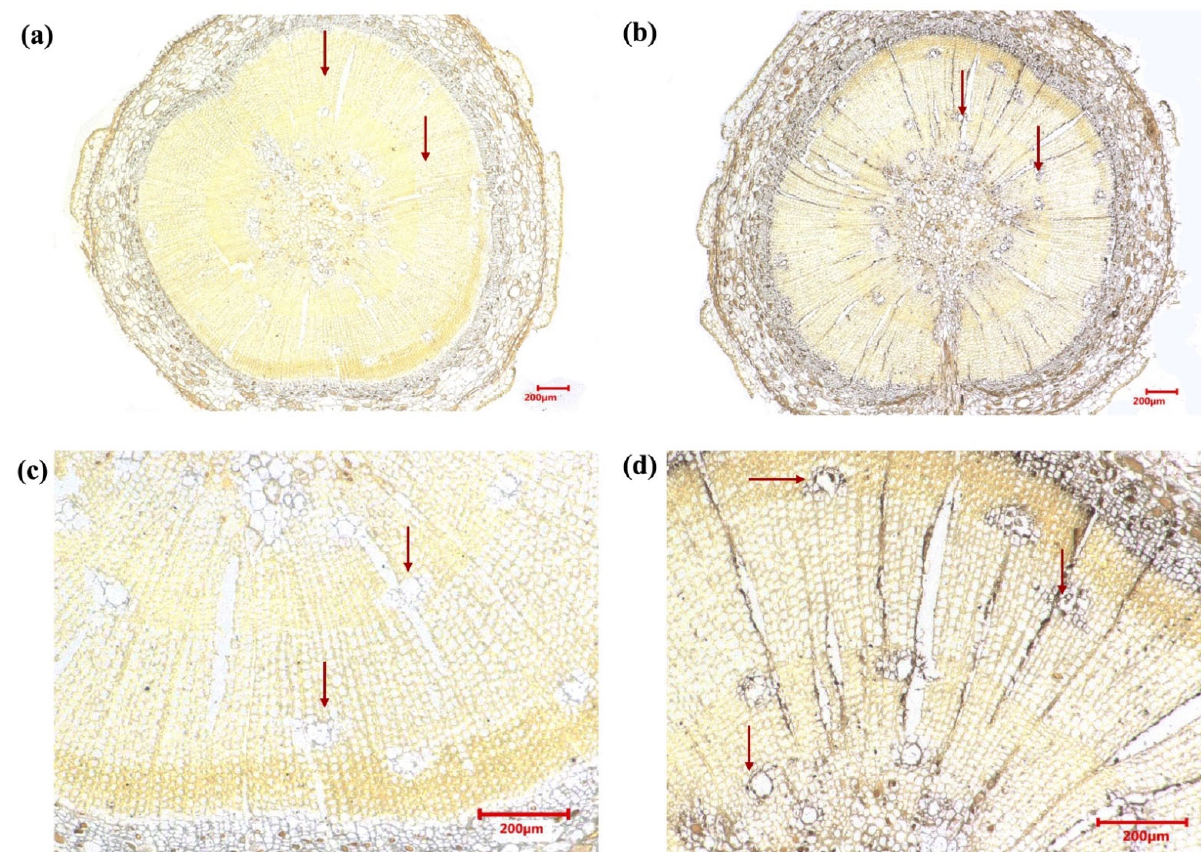
Figure 3. Immunohistochemistry of PmCYP720B11v2 in sections from resistant P. massoniana . ( a ) Zoomed view of primary xylem of the stem, cambia, and phloem in sections of the CK. ( b ) Zoomed view of primary xylem of the stem, cambia, and phloem in sections stained for PmCYP720B11v2. ( c ) Zoomed view of resin ducts in sections of the CK. ( d ) Zoomed view of resin ducts in sections stained for PmCYP720B11v2. CK: negative control group without hybridization of specific antibodies to PmCYP720B11v2. Bars, 200 μ m.